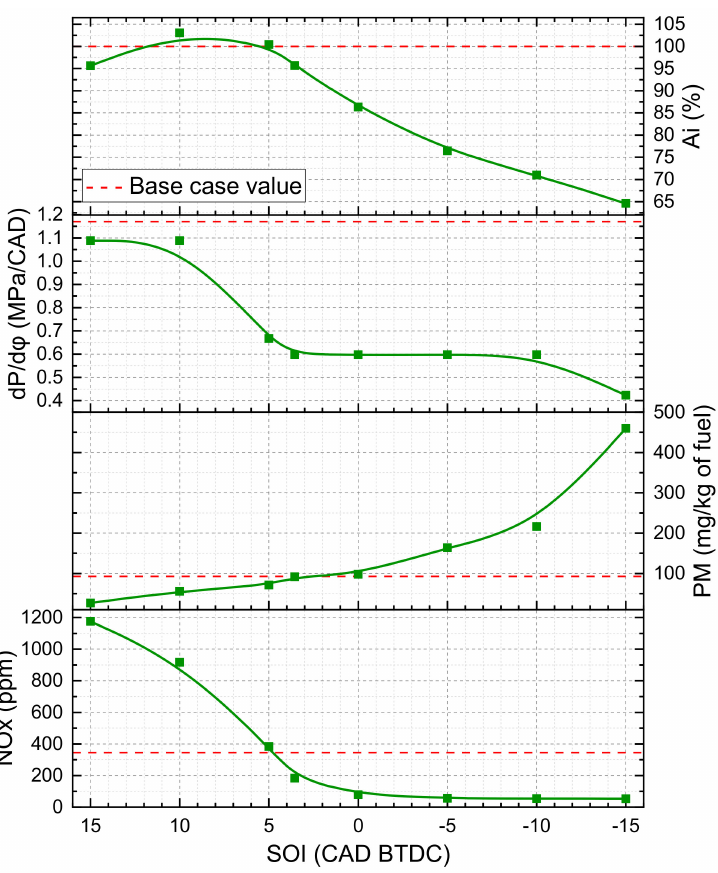
Figure 14. The main SOI variable influence on combustion process and